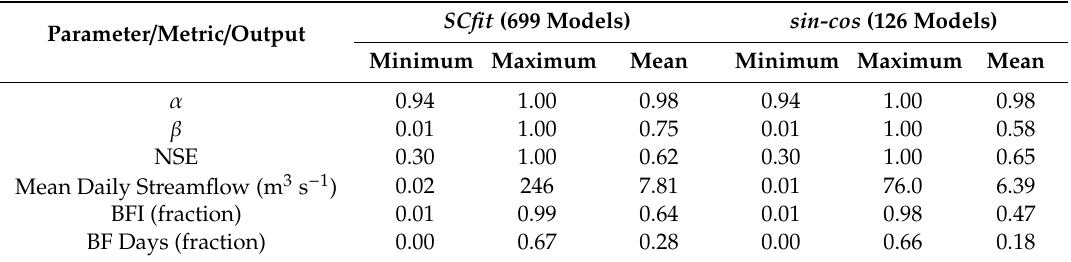
Table 2. Minimum, maximum, and mean values for accepted model parameters, output, and metrics separated by model type ( SCfit or sin-cos ).